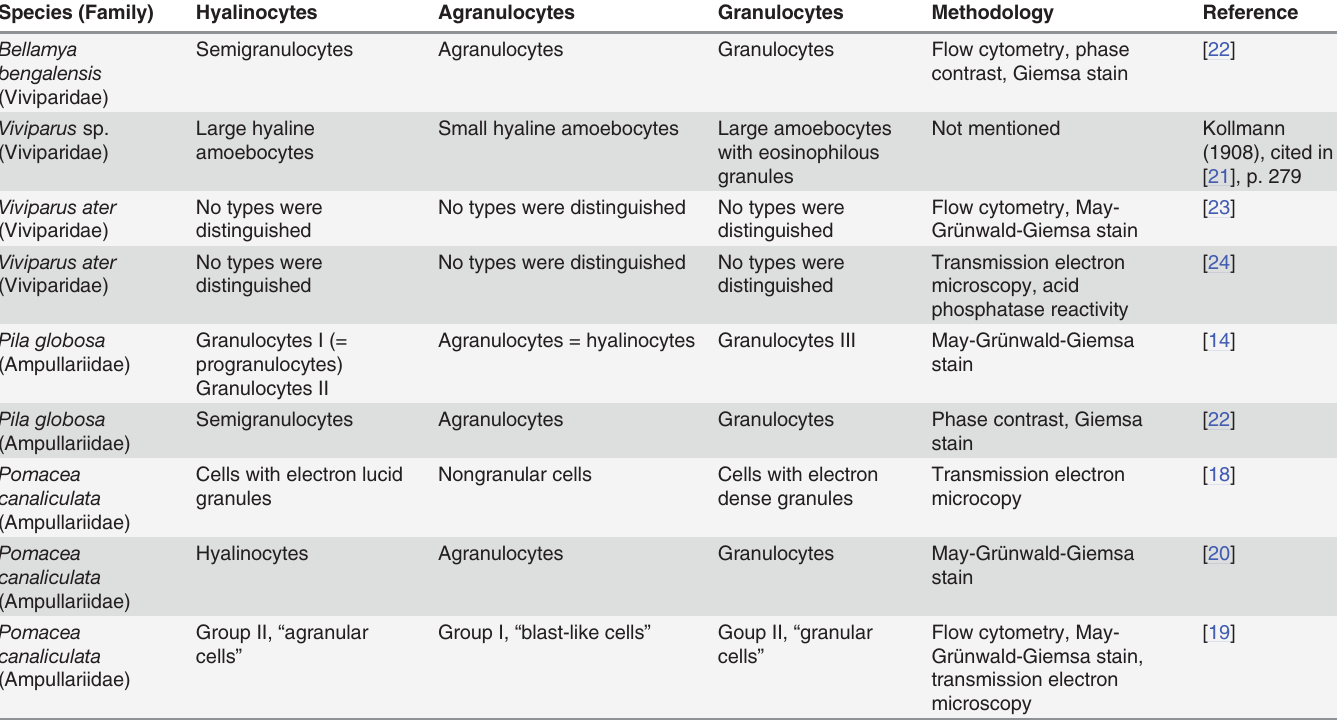
Table 1. Hemocyte types according to Cheng [16] and proposed synonymy in architaenioglossan gastropods (families Viviparidae and Ampullariidae). Species (Family) Hyalinocytes Agranulocytes Granulocytes Methodology